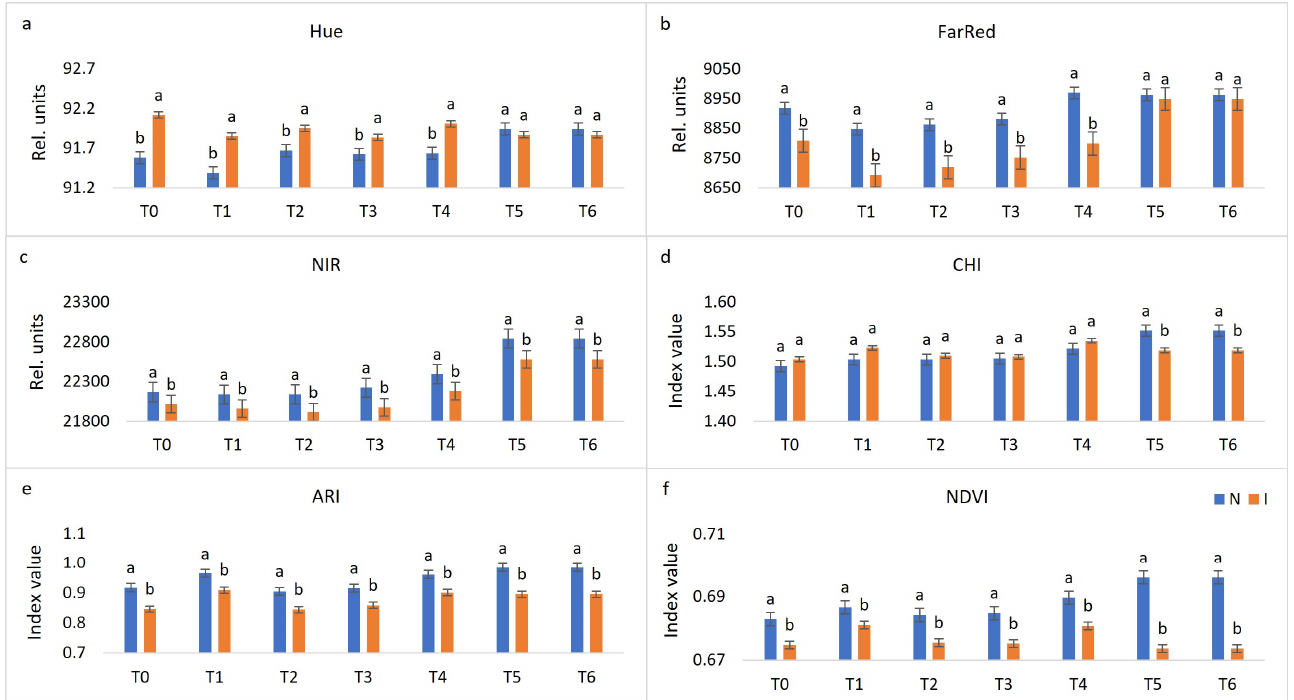
Figure 2. Changes between non-infected (N) and infected (I) leaf discs throughout seven terms (before treatment (T 0 ), one day post-inoculation (dpi) (T 1 ), two dpi (T 2 ), three dpi (T 3 ), four dpi (T 4 ), six dpi (T 5 ) and eight dpi (T 6 )) in multispectral parameters (the average of 30 genotypes). Differences between the means were evaluated by Duncan’s multiple range test at a confidence level of 95% ( p < 0.05). Means with the same letter are not significantly different. Sub-figures depict parameters as follows: ( a ) Hue, ( b ) FarRed, ( c ) NIR, ( d ) CHI, ( e ) ARI, and ( f ) NDVI.